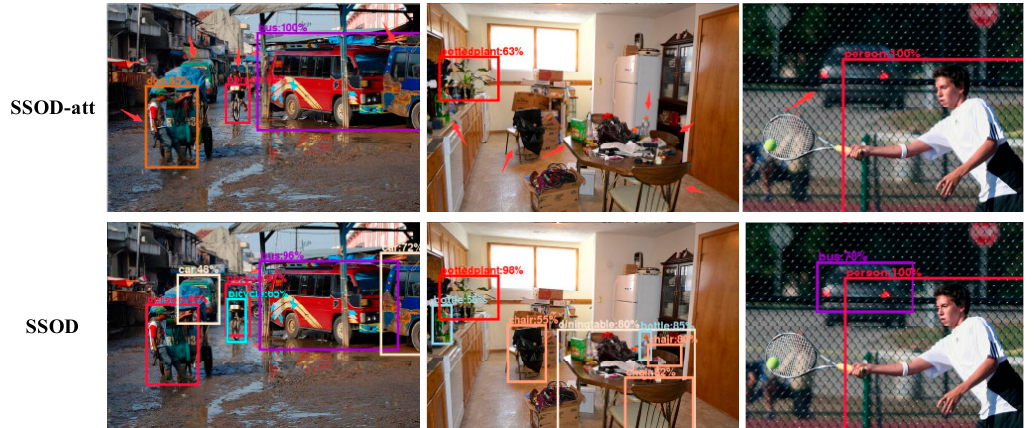
Figure 7. Comparison chart of detection effect between the SSOD algorithm and SSOD-att algorithm. The arrows indicate the objects detected by the SSOD algorithm but missed by the SSOD-att algorithm.